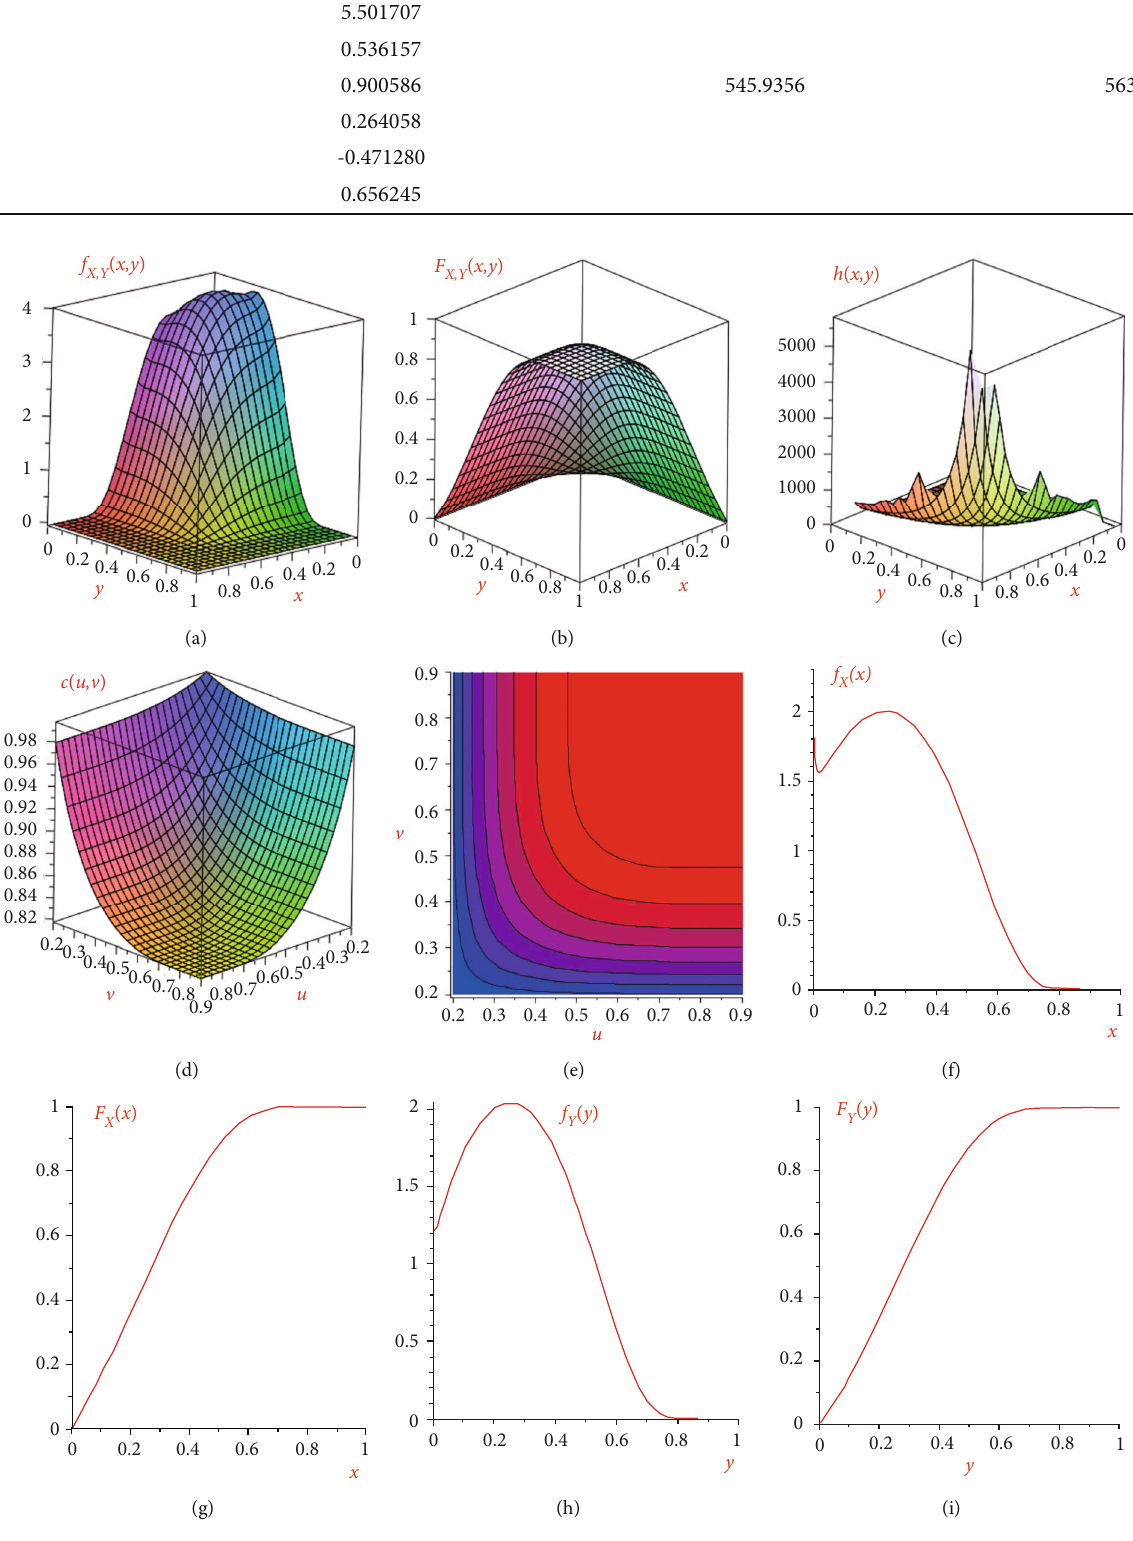
Figure 19: Statistical quantities for ð X , Y Þ ~ BIUPW ð 1 : 5,1 : 6,0 : 8, − 0 : 2, − 0 : 3, − 0 : 5 Þ